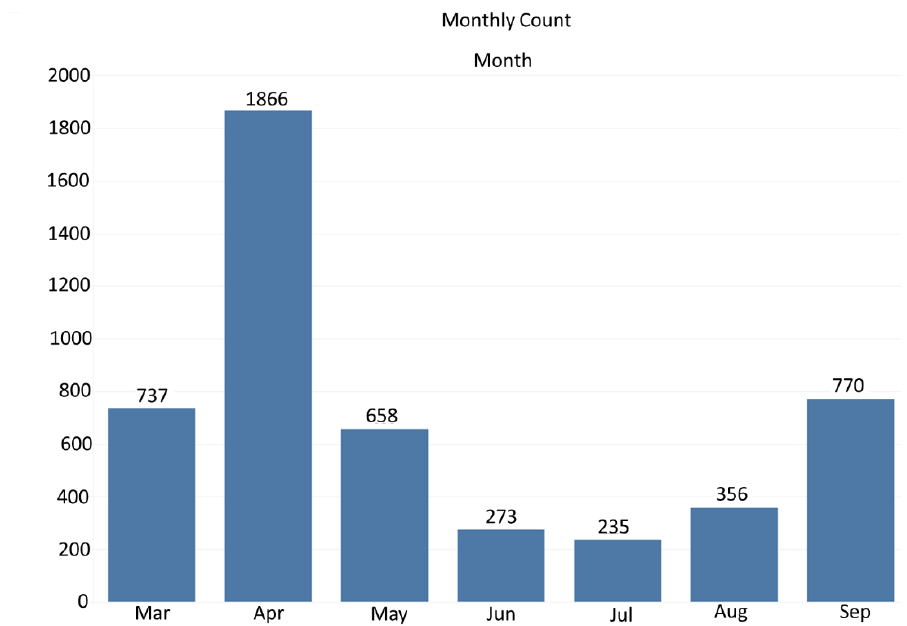
Figure 4. Total number of vaccines provided monthly by the Meharry Medical College-Mobile Vaccination Program from March 2021 to September 2021.